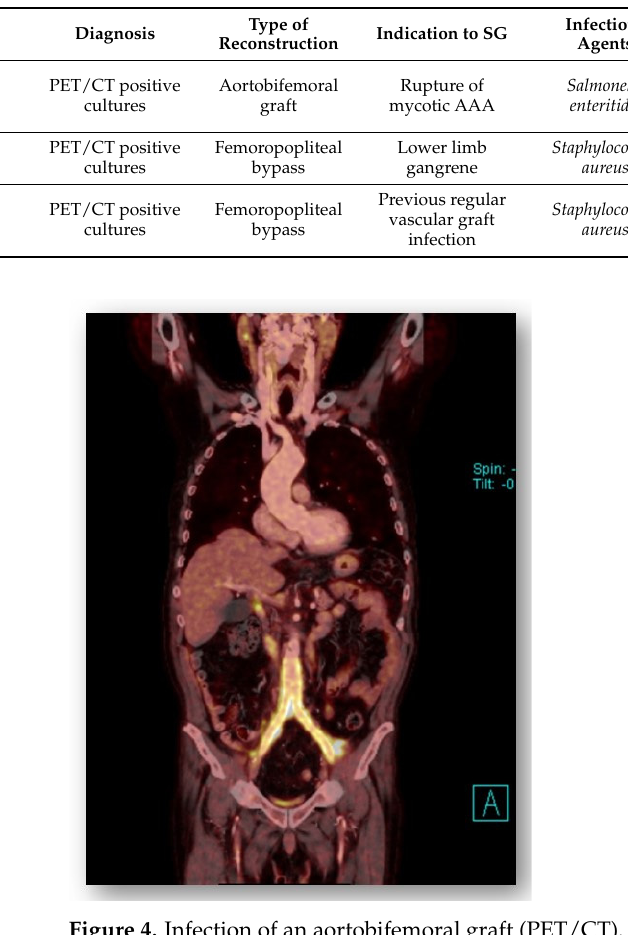
Figure 4. Infection of an aortobifemoral graft (PET/CT).